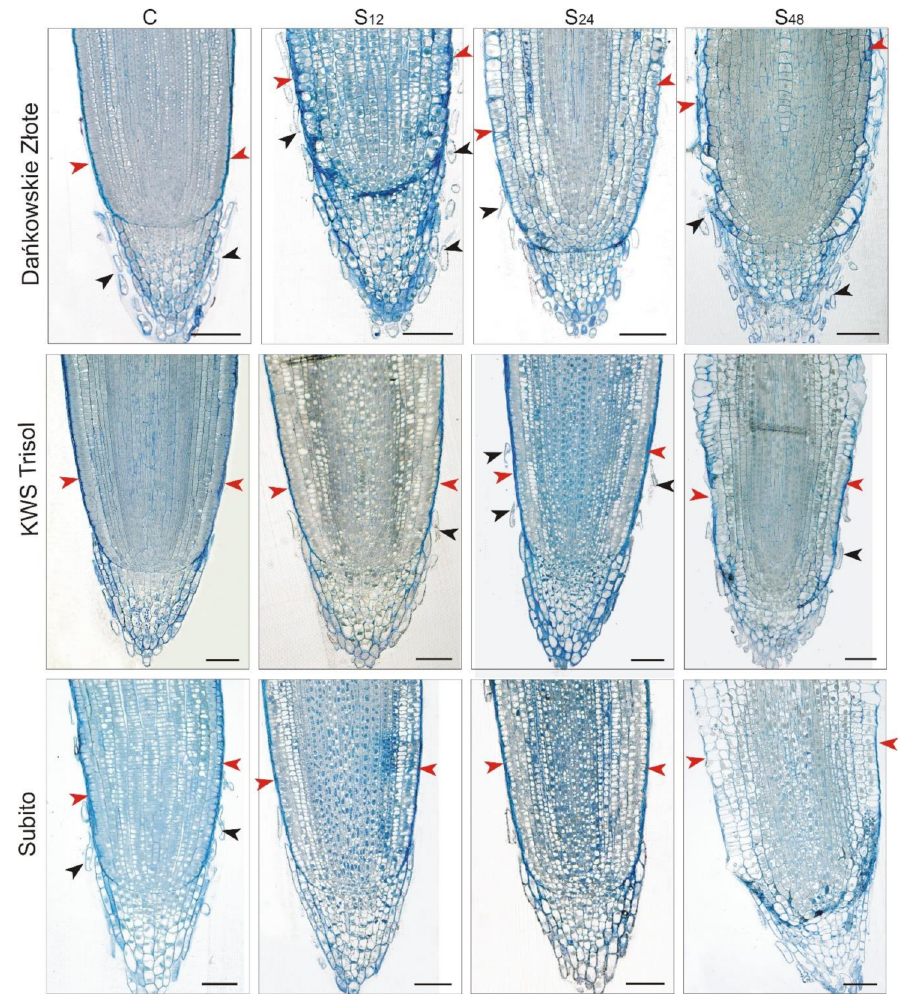
Figure 5. Representative results of the anatomical structure of root tips of tolerant rye cv. “Da´nkowskie Złote”, tolerant triticale cv. “KWS Trisol” and sensitive triticale cv. “Subito” at 12, 24 and 48 h after treatment with Al 3+ (0.59 mM) (S) and in untreated plants (C). Roots sections were stained with an aqueous solution of crystal violet. The anatomical structure of root tips did not change in different sampling points in untreated plants, so only one representative control is shown (C). The red arrowheads show the rhizoderm, while the black ones root border cells. Bar= 100 µ